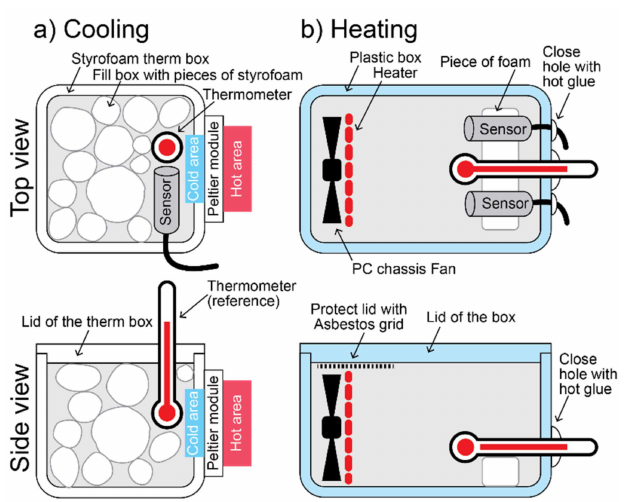
Figure 1. Schematic representation of the setup for the T calibration of the AM2315 sensor. ( a ) Cali- bration of the lower temperatures relative to room T using a cooling process. ( b ) Calibration of the higher temperatures using a heating process.